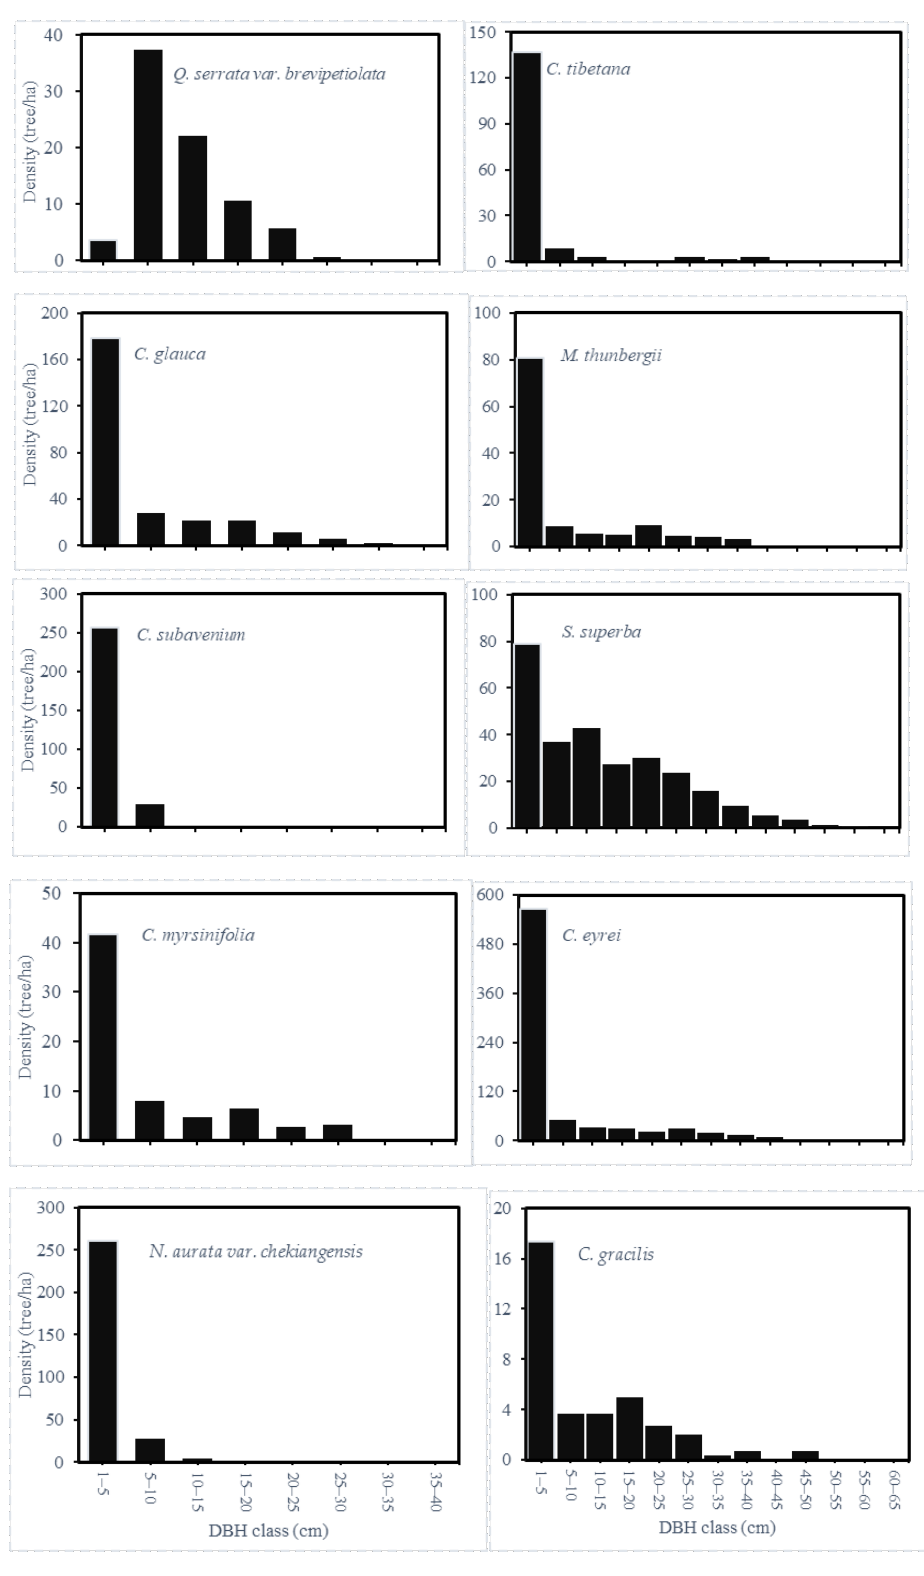
Figure 2. The DBH class distributions of dominant species in the old-growth forest.